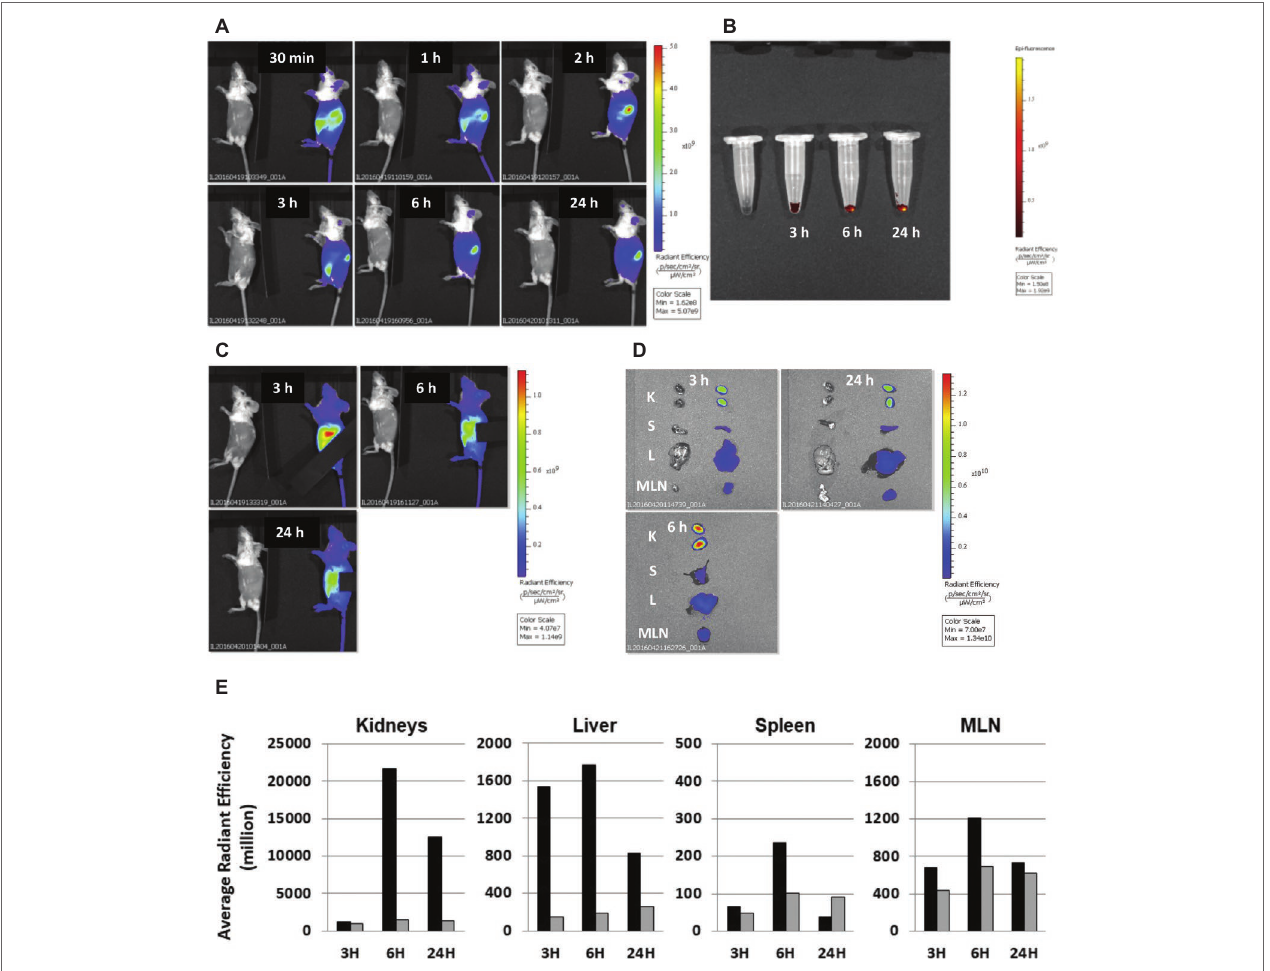
FIGURE 1 | Whole body fluorescence imaging of AvBD7 in vivo and ex vivo post intraperitoneal injection in mice. Mice were injected with 100 μl of either H 2 O alone (negative control, left part of each image) or containing 100 μg of fluorescence-labeled AvBD7 or containing the same amount of free dye (according to absorbance measurement at 750 nm). Times for image acquisition are indicated on each image. (A) Mice imaged on left lateral view. (B) Pelleted peritoneal cells collected from control (left) or fluorescent AvBD7-injected mice. (C) Mice imaged on left lateral view, hiding the kidneys area. (D) Organs imaged ex vivo (K, kidneys; S, spleen; L, liver; MLN, mesenteric lymph node). (E) Quantification of AvBD7 fluorescence (black bars) by comparison to that of the free dye fluorescence (grey bars) in organs collected post i.p. injection in a sacrificed animal at three indicated times (in h). Values are given in million average radiant